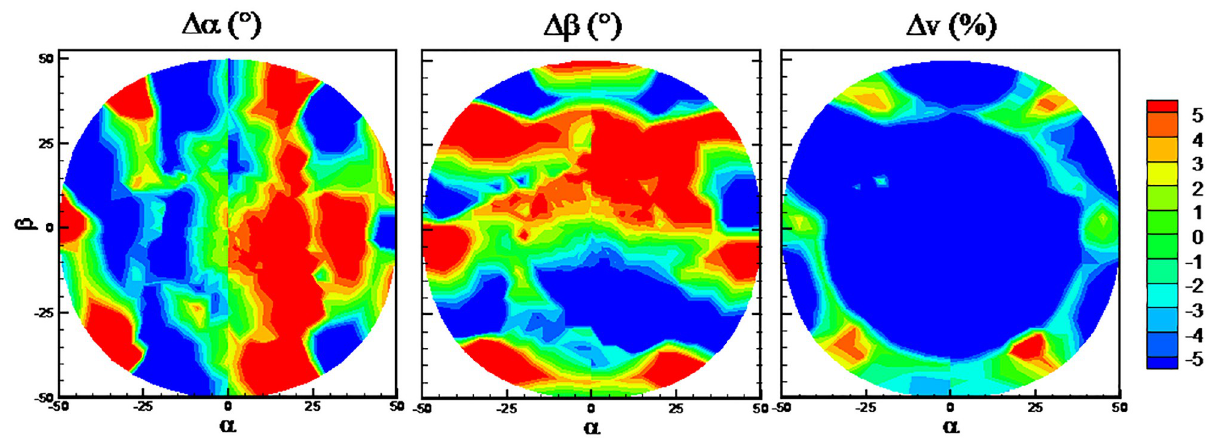
Fig 24. Error distributions with RFs